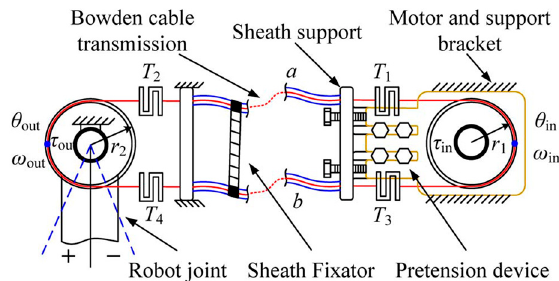
Figure 2. The schematic diagram of a double tendon–sheath. In the figure, tendons a and b are attached to the input side pulley and output side pulley with a pull‑pull configuration τ in and τ out are the input and output torque, θ in and θ out are the input and output angles, ω in and ω out are the angular velocities of input and output, and r 1 and r 2 are the radius of the pulleys. The tendon transmits the force and torque by mechanical displacement in the inner tendon.